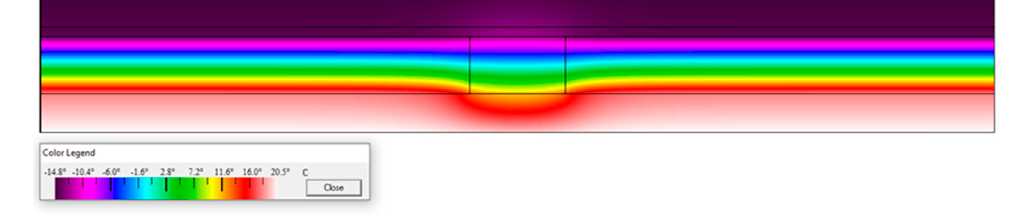
Figure 10. Distribution of the temperature field in the calculation model for the variant with a 30 mm VIP and a 50 mm gap between VIPs.